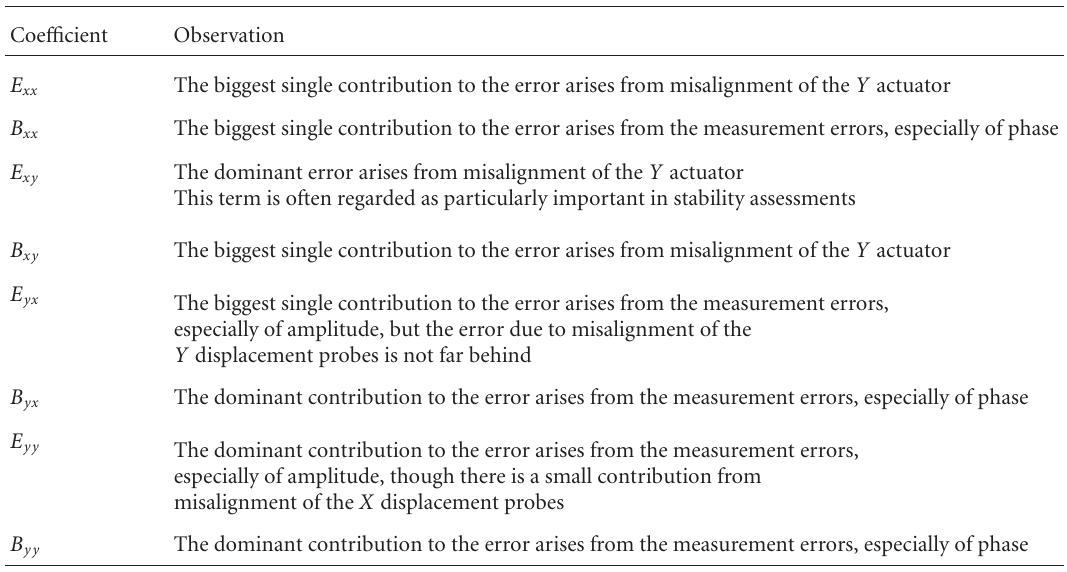
Table 4: Descriptive summary of coe ffi